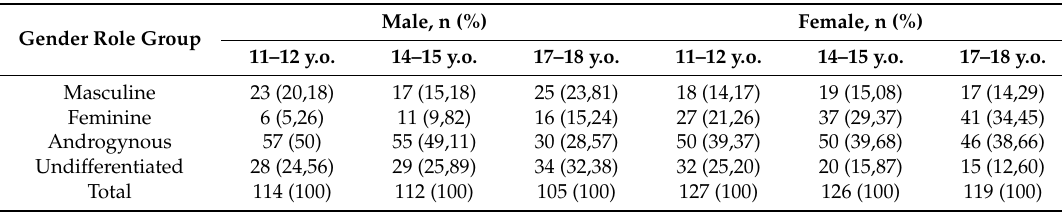
Table 1. Distribution of gender identity types among the boys and girls at 11–12, 14–15 and 17–18 years